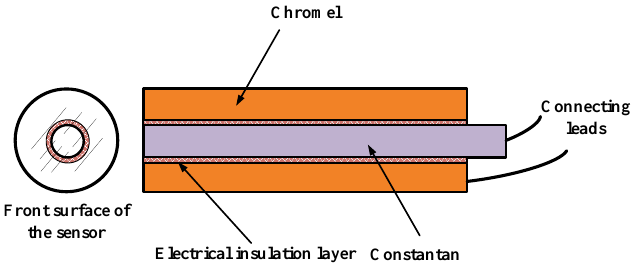
Figure 1. Schematic diagram of the coaxial surface thermocouple.